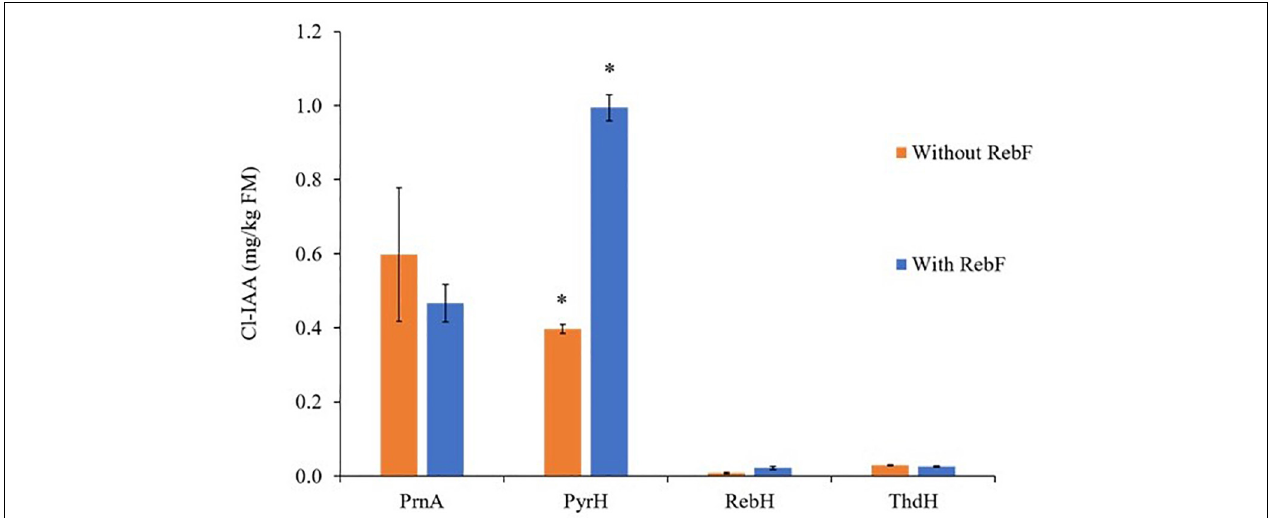
FIGURE 5 | Free Cl-IAA production above background levels in N. benthamiana leaves following co-infiltration of AtTAA1, AtTAR2, PsYUC7 and one of four flavin-dependent halogenases with and without the partner reductase, RebF. Bars represent mean ± SEM, n = 4, except for RebH without RebF and PyrH with RebF for which n = 3. * indicates significant difference following a two-sample, two-tailed Welch’s t -test in RStudio, p ≤ 0.005. A Shapiro–Wilks test was used to verify that the Cl-Trp production by each replicate leaf followed a normal distribution. The outcome of the t -test cannot be relied upon for the comparison between ThdH+/– RebF, as the replicate Cl-IAA yields for ThdH + RebF are not normally distributed.